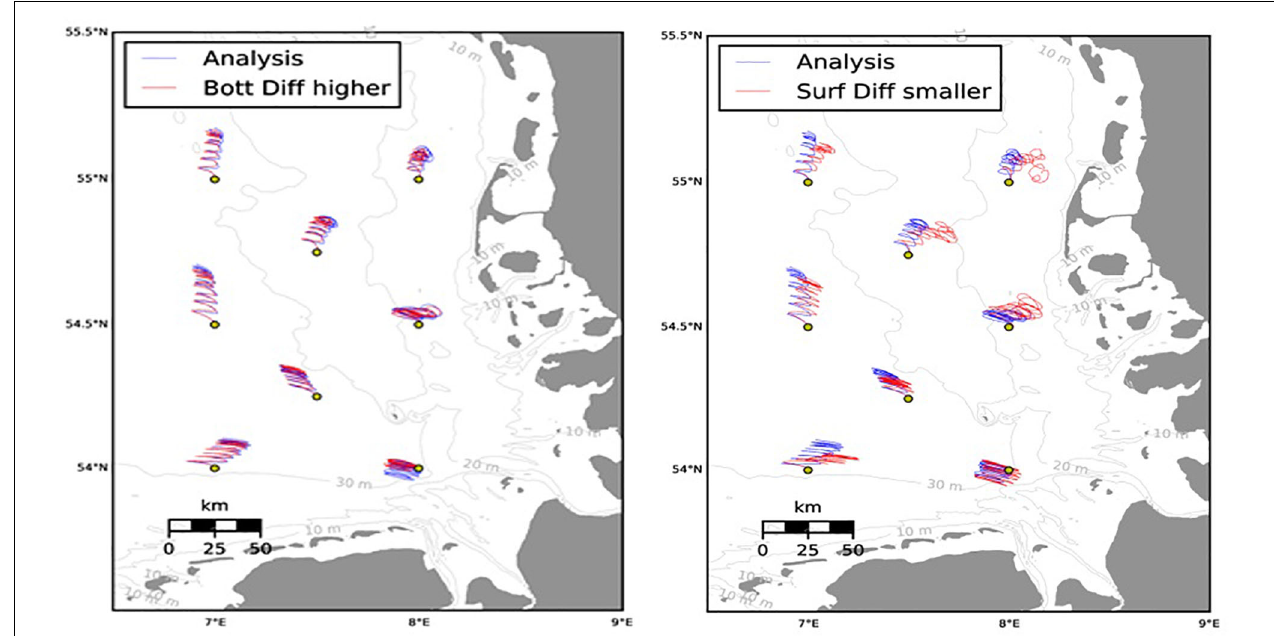
FIGURE 12 | Comparisons of surface drift trajectories derived from analyzed model runs (blue trajectories) against first guess runs (red curves) over a period of 5 days for the German Bight pilot case. The yellow dots indicate the release locations. The red trajectories in the left plot are based on a higher bottom roughness estimation. The red trajectories in the right plot are related to a reduction of the momentum diffusion in the surface layer. The pictures also show the 10, 20, and 30 m isobaths in the domain, superimposed as gray lines.